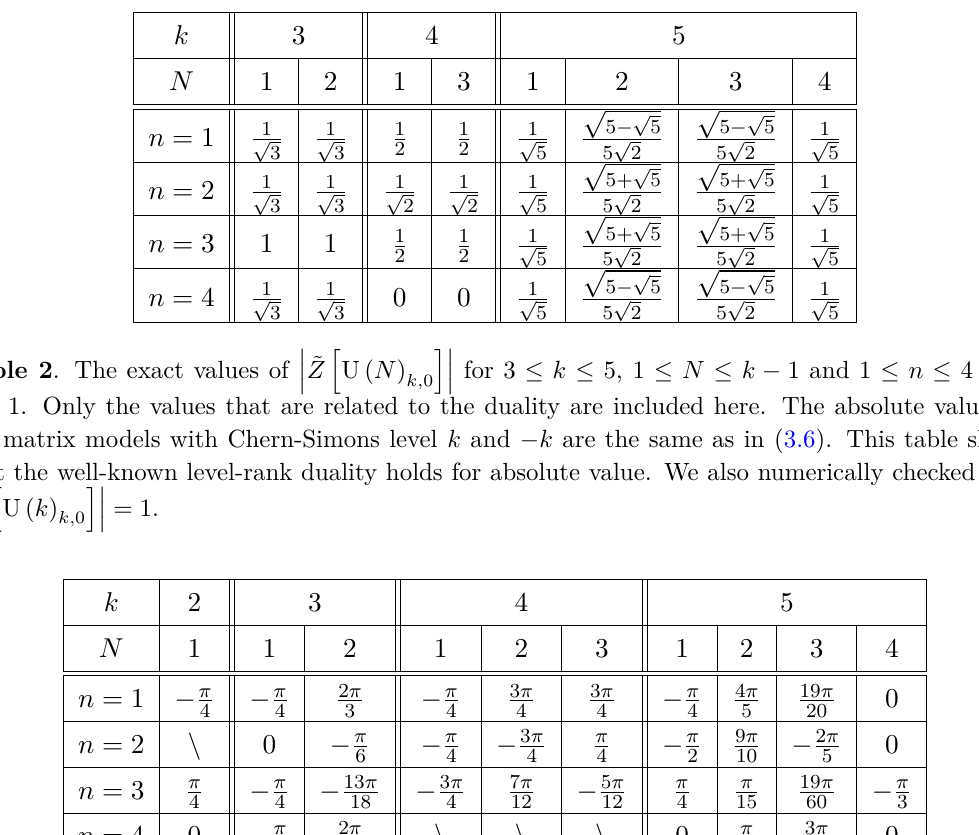
Table 3 . The exact values of the phases of ˜ Z matrix model is 0 . The value with negative k can be obtained by taking the complex conjugate as in (3.6). The duality between U ( N )